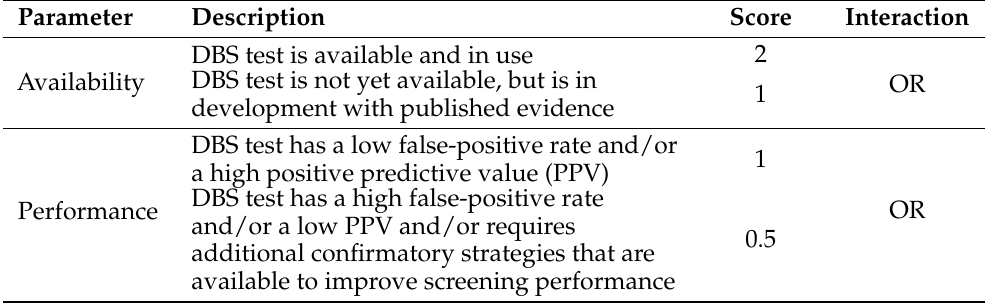
Table 4. Components of Pillar 2, Screening.